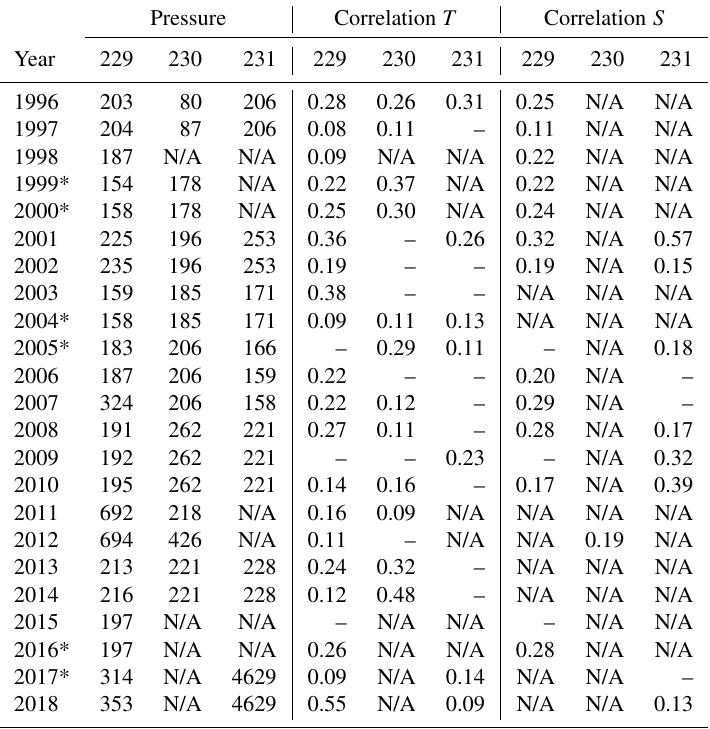
Table B2. Left: median pressure (dbar) of the shallowest temperature sensor on each mooring line (columns) for each year over the period 1 July–31 October. Middle: correlation coefficient over that same period between the temperature ( T ) of that shallowest sensor and the infrared brightness temperature T4 at the same location. Right: correlation between the salinity ( S ) of the shallowest sensor and T4. Only significant correlations are indicated; insignificant correlations at the 95% confidence level are indicated with a “–”; absence of sensor or data is indicated with “N/A”. Years with a polynya event are highlighted with an asterisk (*). Pressure Correlation T Correlation